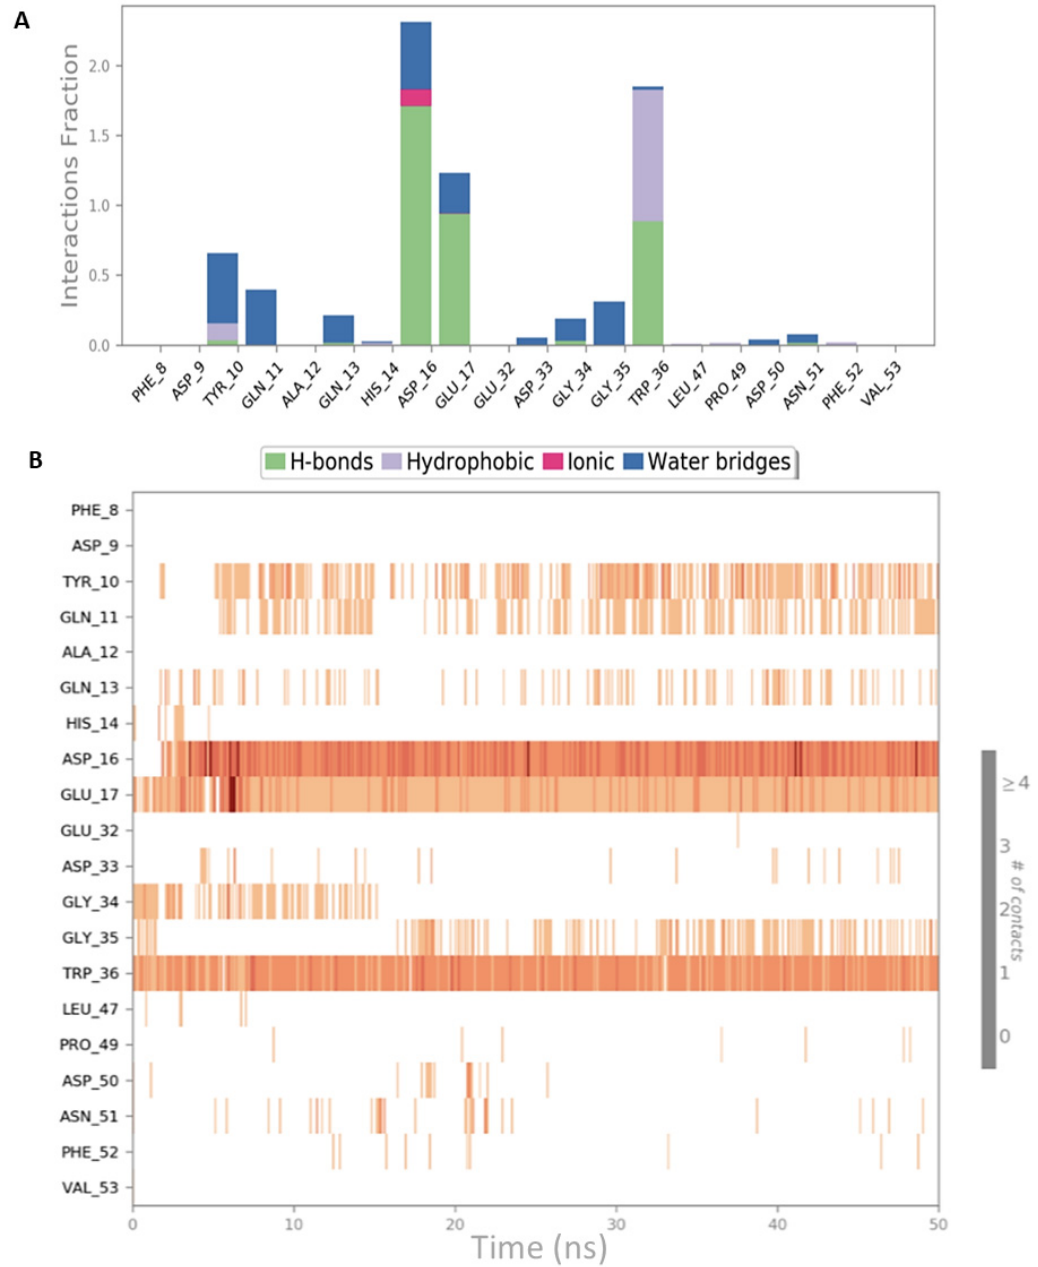
Figure 10. Schematic representations of the interactions occurring in the second MD simulation of the complex MUC1-CIN85 monomer. ( A ) Histogram plot highlighting the CIN85 residues involving in the interactions with MUC1. ( B ) Timeline representations of the interactions during the MD simulation.